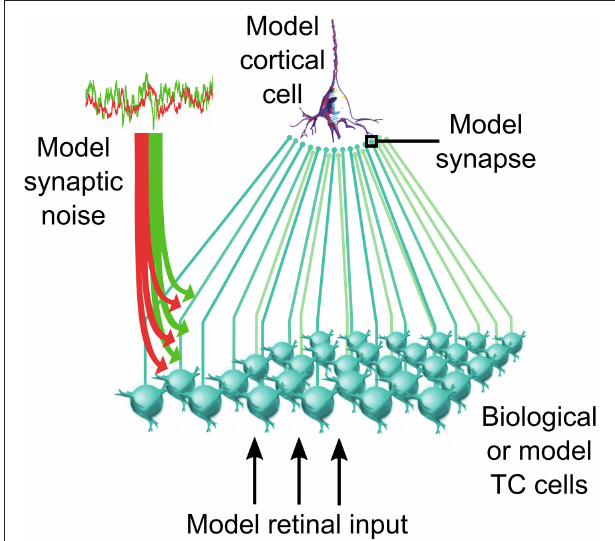
FIGURE 5 | Thalamocortical convergent circuit. Biological or model TC cells network synaptically converge to a model recipient cortical neuron. The thalamic population receives a model retinal input in addition to a corticothalamic input mimicked through the injection of stochastically fluctuating mixed excitatory and inhibitory conductances. Details on the implementation of this circuit are available in Béhuret et al.